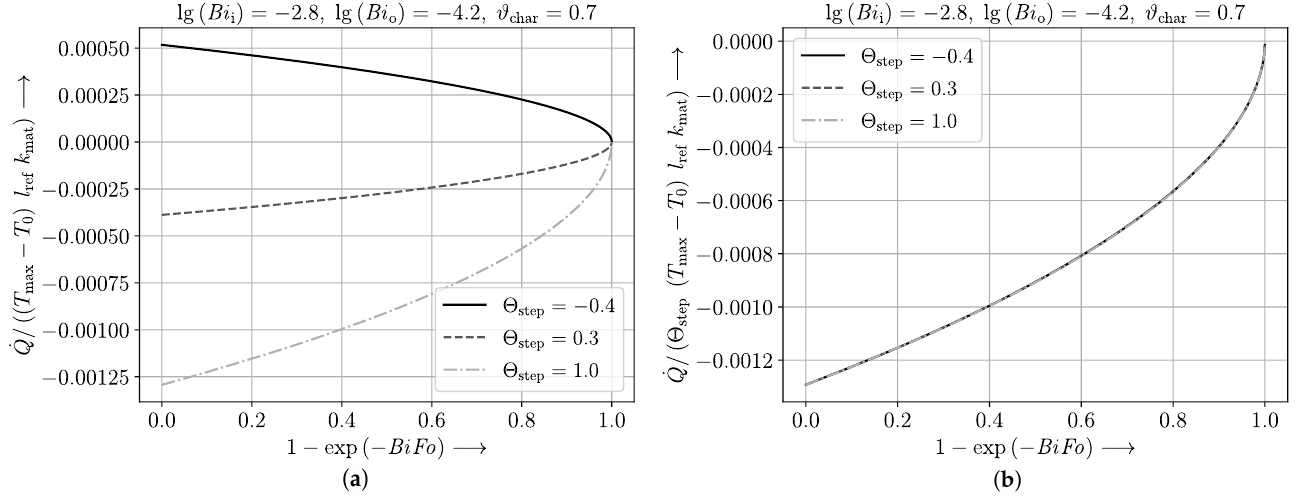
Figure 5. ( a ) Non-dimensional heat transfer map for varying step changes; ( b ) non-dimensional heat transfer map after referring heat flow to step